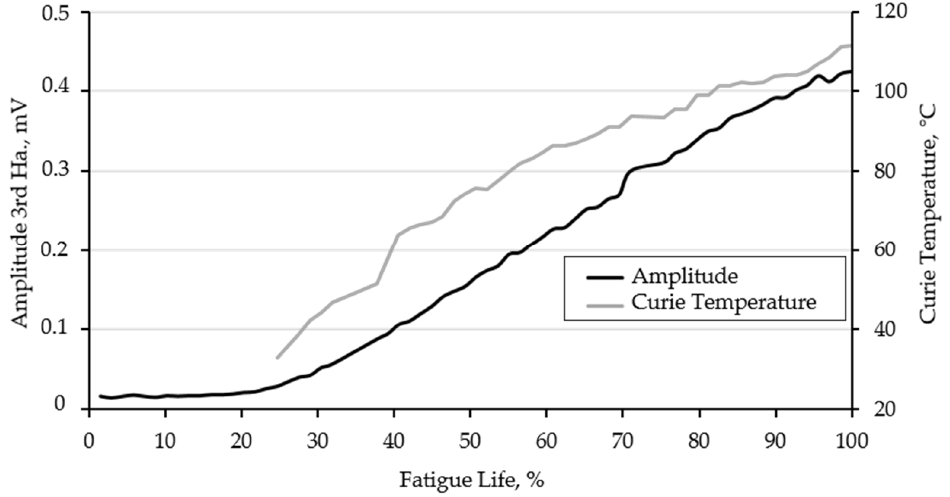
Figure 6. Amplitude of the third harmonic and Curie temperature versus fatigue life of the specimen subjected to 0.5% strain amplitude at 800 °C .